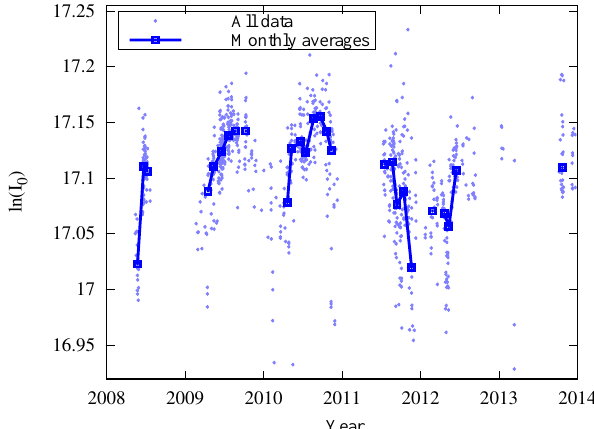
Figure 7. Scatterplot between AOD estimates by the Cimel and the Brewer for the period